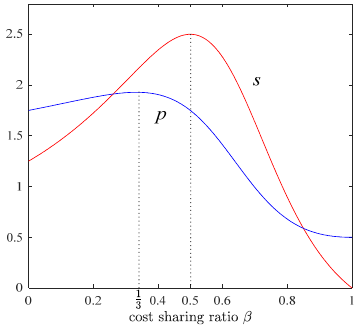
Figure 2. Pricing and service decisions in Scenario U.